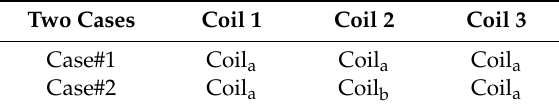
Table 2. Configuration of three coils for two cases.